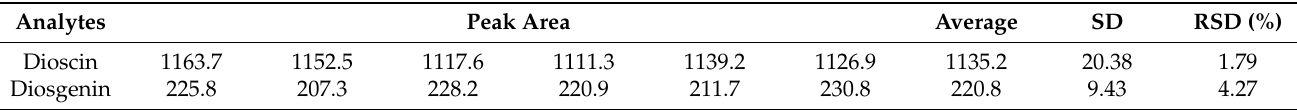
Table 4. Results of experimental precision ( n = 6).